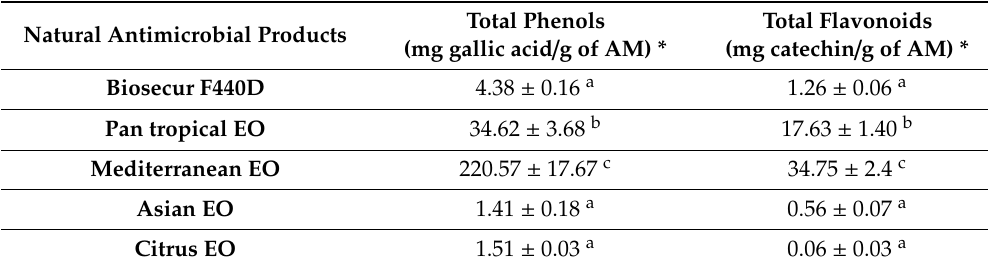
Table 4. Total phenols and total flavonoids content of the antimicrobial extracts. Natural Antimicrobial Products